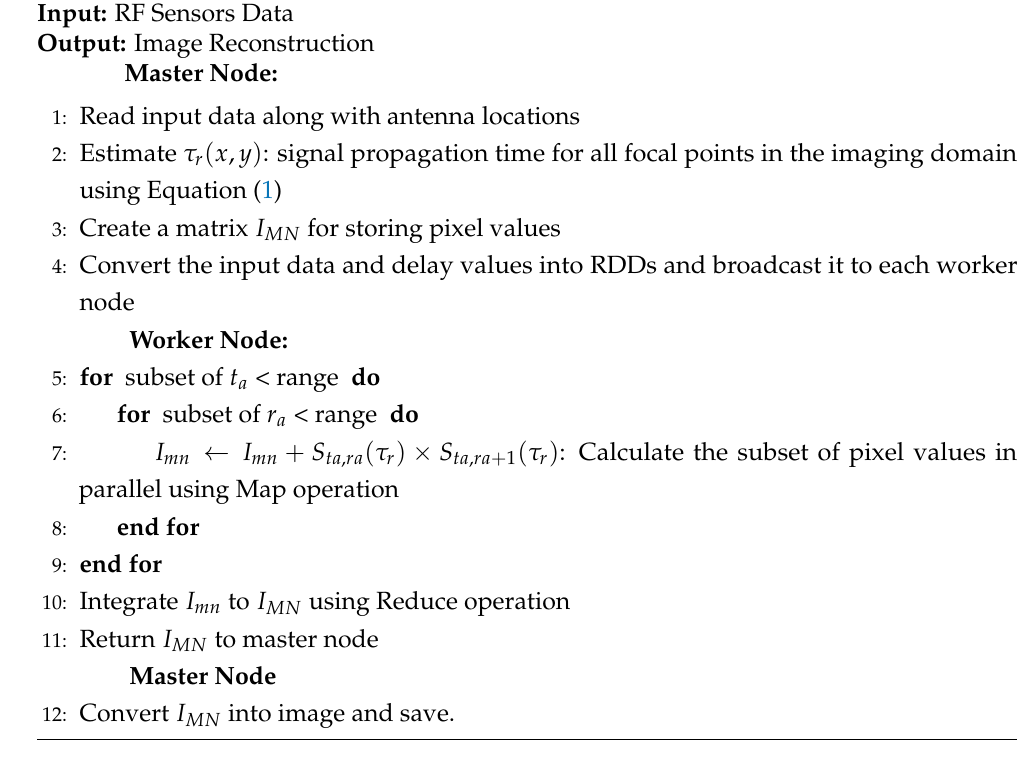
Algorithm 1 PDMAS algorithm using